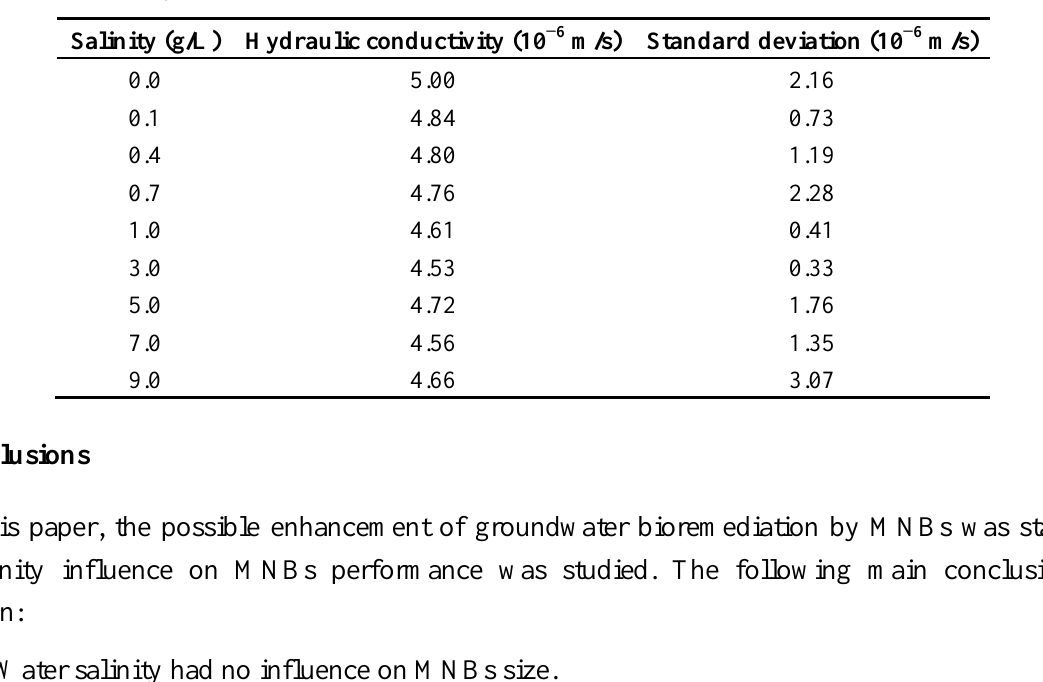
Table 3. Hydraulic conductivities of sand with MNBs water in different